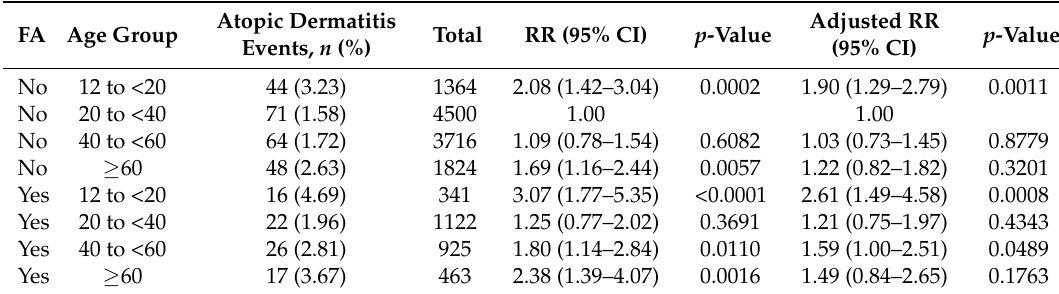
Table 3. Early food allergy in adolescents is associated with Atopic dermatitis (AD) according to combined effects of food allergy and age group.